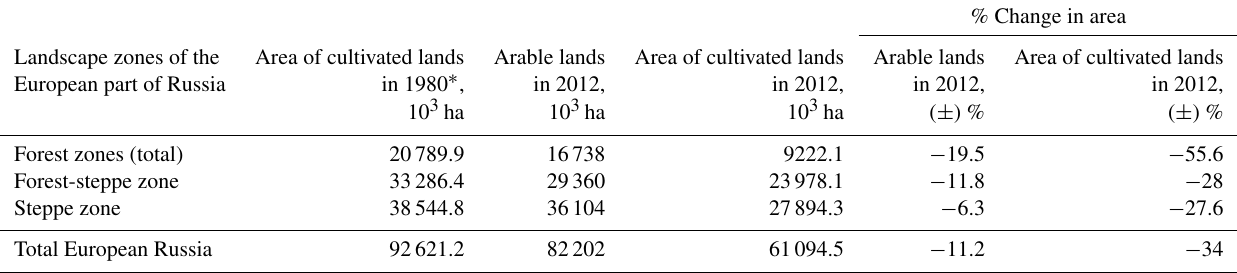
Table 2. Changes in the areas of arable and cultivated lands in the landscape zones of the RP between 1980 and 2012.